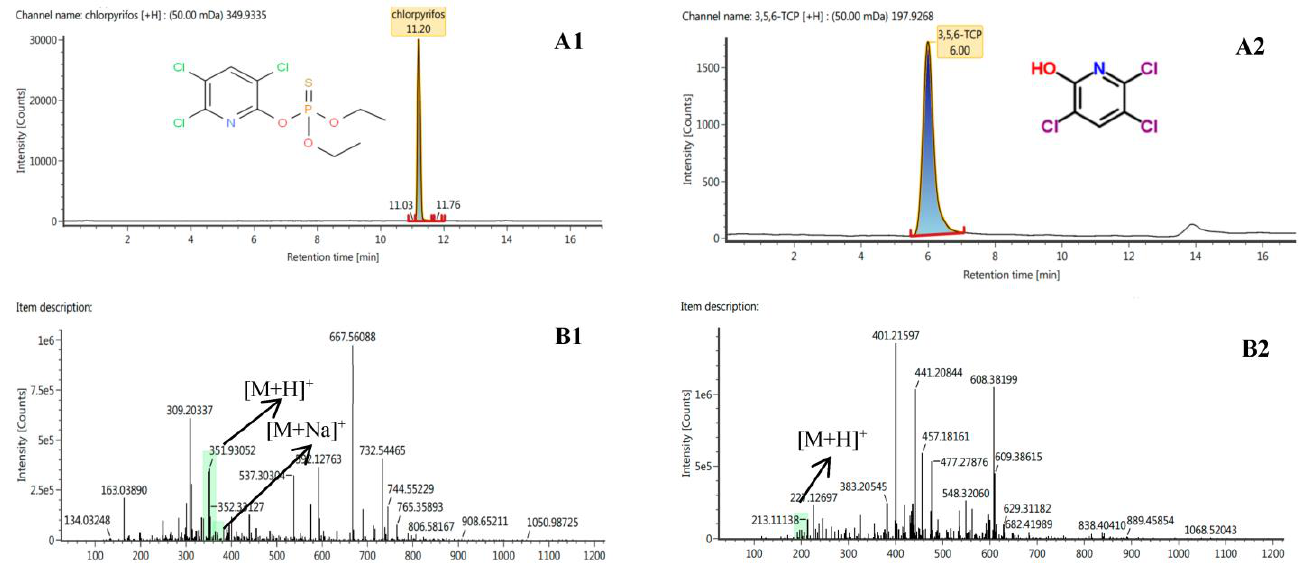
Figure 1. UPLC-QTOF/MS-extracted ion chromatogram and MS E spectra of chlorpyrifos and 3,5,6-TCP: ( A1 ) chlorpyrifos standard at 100 ug/kg in wheat sample; ( A2 ) 3,5,6-TCP standard at 100 ug/kg in wheat sample; ( B1 ) the low collision energy adducts of H + , Na + chlorpyrifos; ( B2 ) low-collision-energy adducts of H + , 3,5,6-TCP.